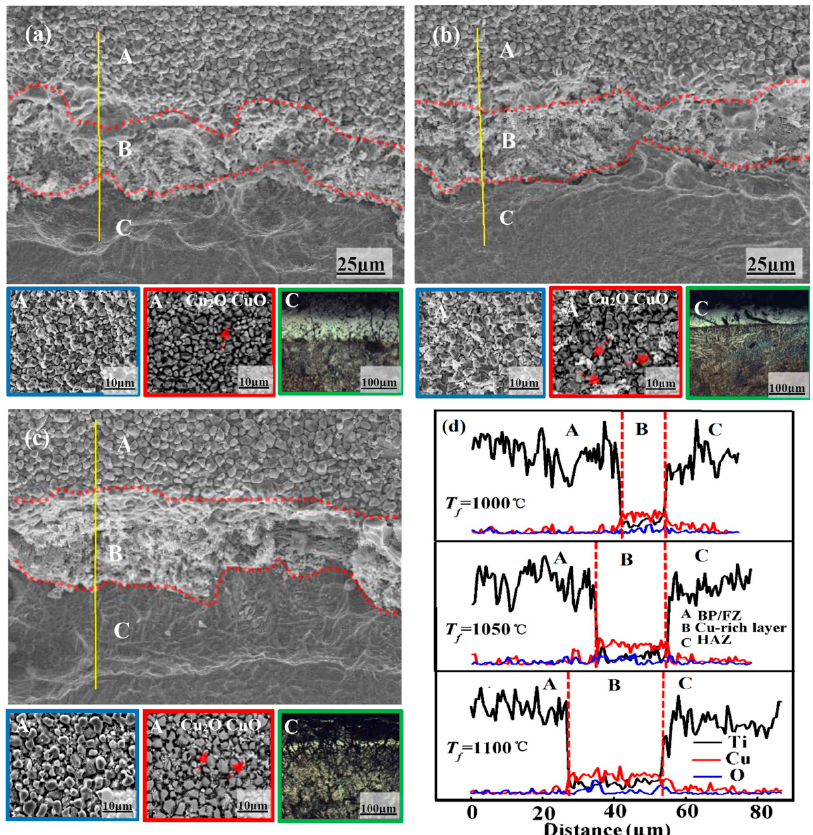
Figure 7. The SEM image of the burned Ti14 alloy as obtained from the forging temperature of: ( a ) 1000; ( b ) 1050; and ( c ) 1100 °C ( C o = 20%). A, B, C represent the BPZ/FZ, Cu-rich layer, and HAZ, respectively. The first two insets for each figure are the SEM (blue frame) and SEM-BSE (red frame) surface morphologies of the burning products, respectively. The last inset for each figure is the OM image (green frame), which shows the microstructure of Ti 2 Cu precipitates in HAZ from the corresponding Ti14 sample after burning; and ( d ) EDS of the burned structures which clearly show the distribution of Cu.